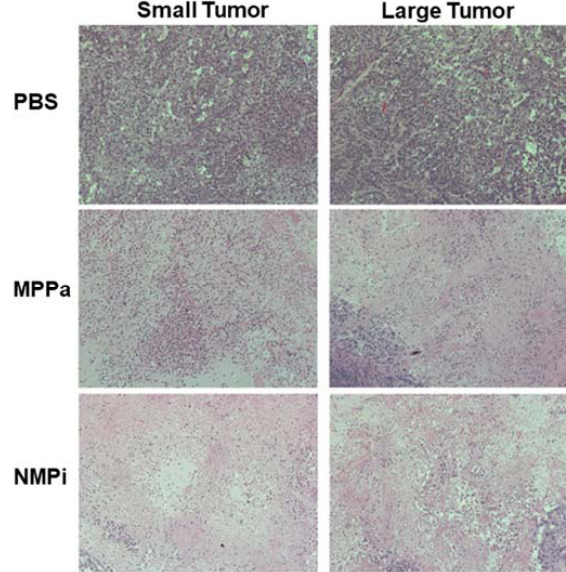
Figure 9. Hematoxylin and eosin (H&E) staining of tumor tissues in A549 tumor ‐ bearing mice (small ‐ tumor group <50 mm 3 and large ‐ tumor group >50 mm 3 ) on Day 15, after double intravenous injection (on Days 0 and 2, repeated two times PDT) of PBS, MPPa (2 mg/kg) and NMPi (2 mg/kg) with 200 J/cm 2 light irradiation on one day after each injection (on Days 1 and 3, repeated two times PDT). Mice in the small tumor group treated with NMPi presented the most complete tumor cell eradication, which was also consistent with the result of tumor surface alterations in Figure 8. The magnification is 40 × .